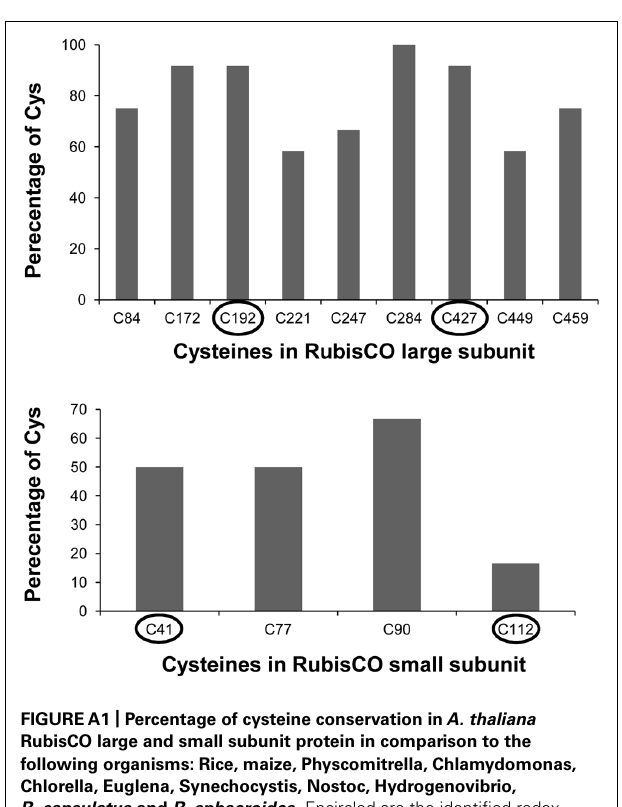
FIGUREA1 | Percentage of cysteine conservation in A. thaliana RubisCO large and small subunit protein in comparison to the following organisms: Rice, maize, Physcomitrella, Chlamydomonas, Chlorella, Euglena, Synechocystis, Nostoc, Hydrogenovibrio, R. capsulatus and R. sphaeroides . Encircled are the identified redox sensitive cysteines.